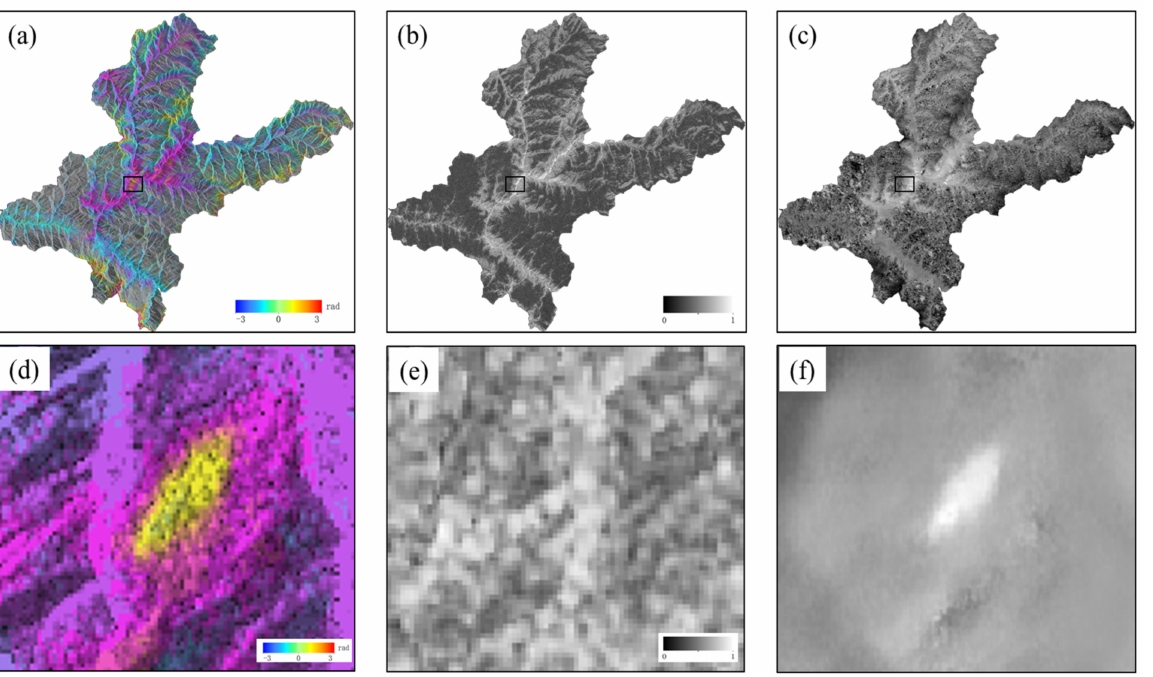
Figure 5. Interferogram and partial amplified diagram of 20170219-20170303 descending orbit data. Interferogram and partial amplified diagram of 20170425-20170507 ascending orbit data. ( a ) is the overall interferogram of Maoxian county, ( b ) is the coherence coefficient diagram of Maoxian county, ( c ) is the unwrapping results of Maoxian County, ( d ) is the partial amplified interferogram, ( e ) is the partial amplified coherence coefficient diagram, and ( f ) is the partial amplified unwrapping